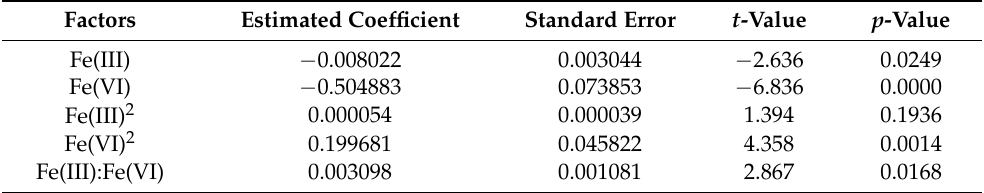
Table 4. Local polynomial regression adjustment to assess the effects of Fe(III) and Fe(VI) on the final arsenic concentrations at the initial concentration of 500 µ g L − 1 of As(III) and 500 µ g L − 1 of